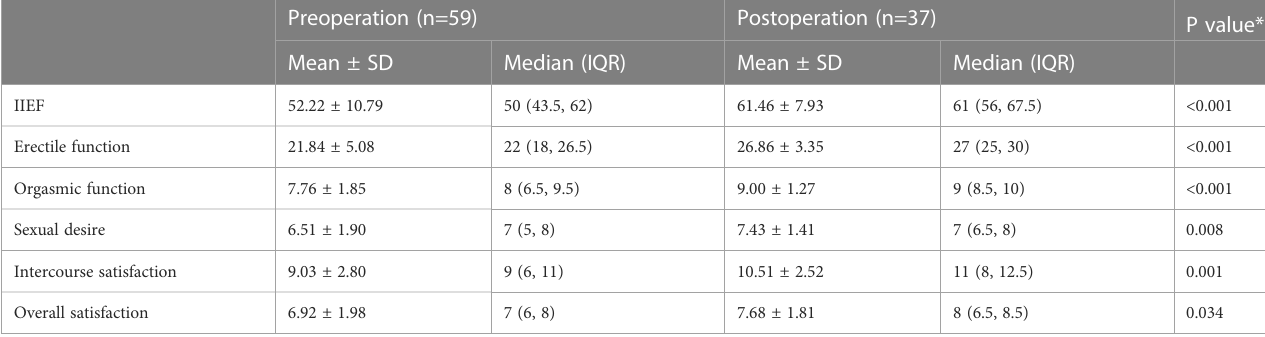
TABLE 4 Changes of IIEF score and its fi ve domains.